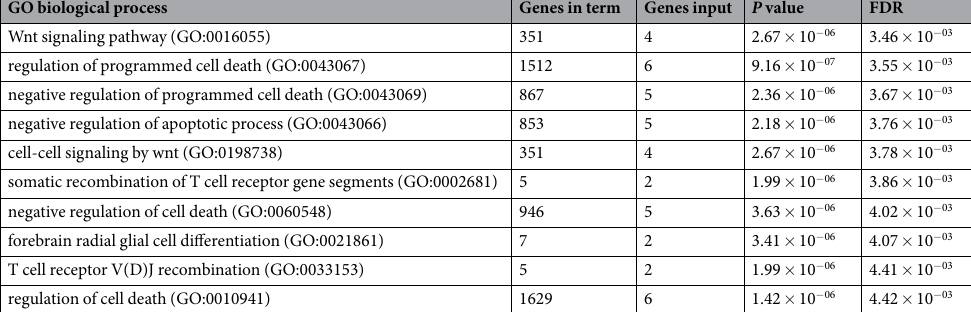
Table 3. Enrichment analysis of biological process for potential